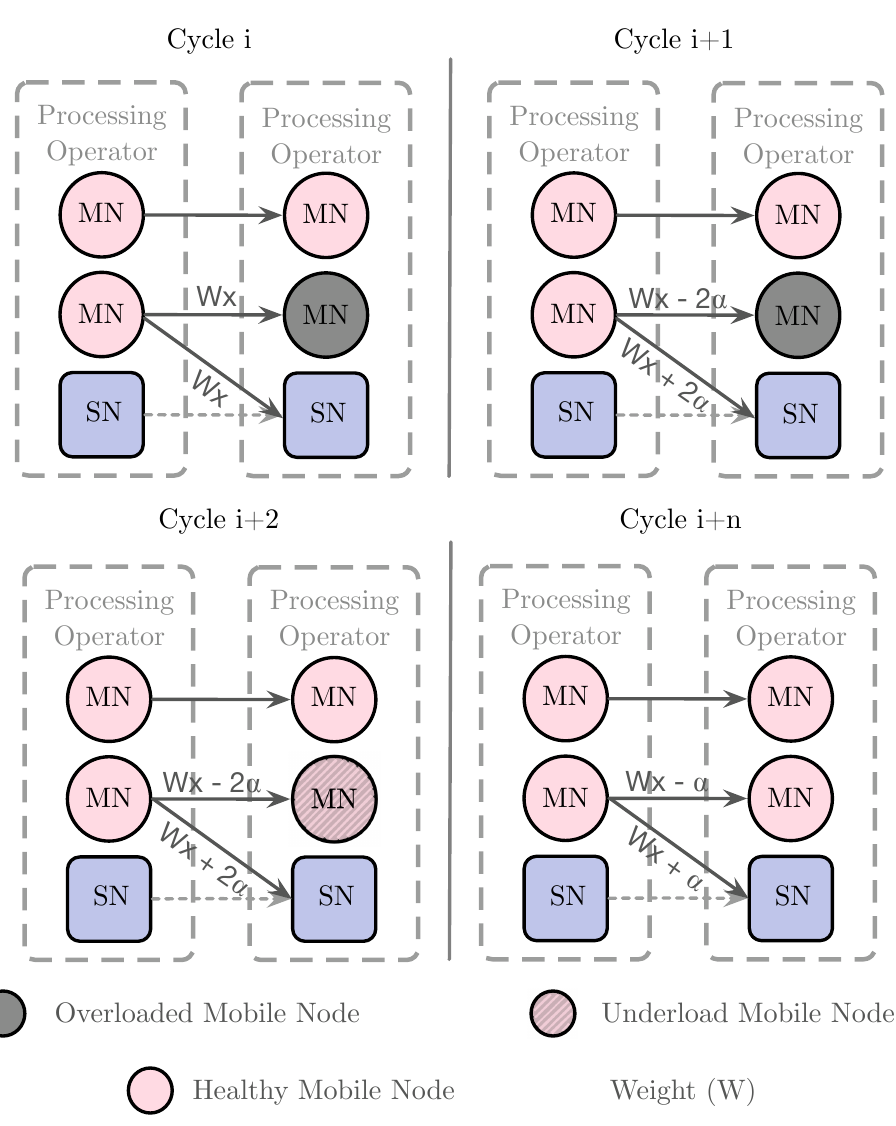
Figure 4. Example of the weighted round−robin scheduling